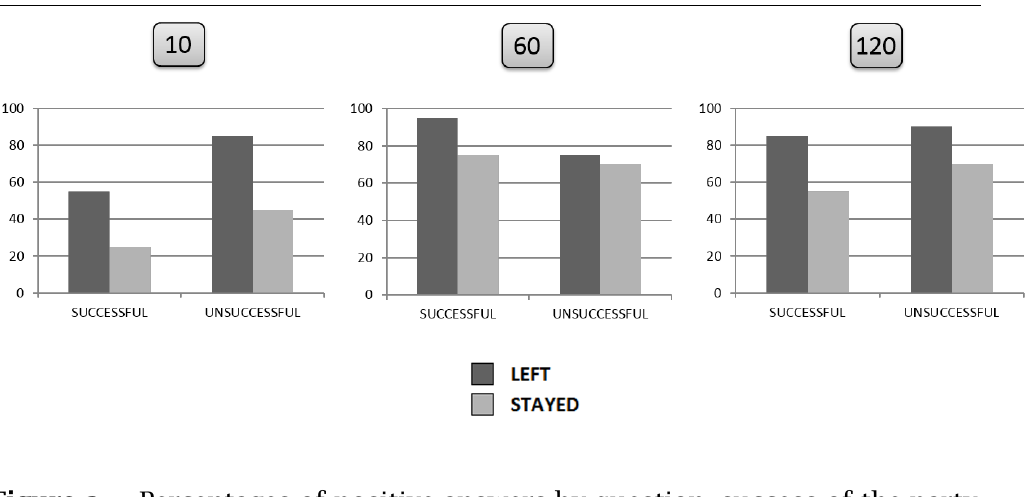
Figure 3 Percentages of positive answers by question, success of the party, and total number of